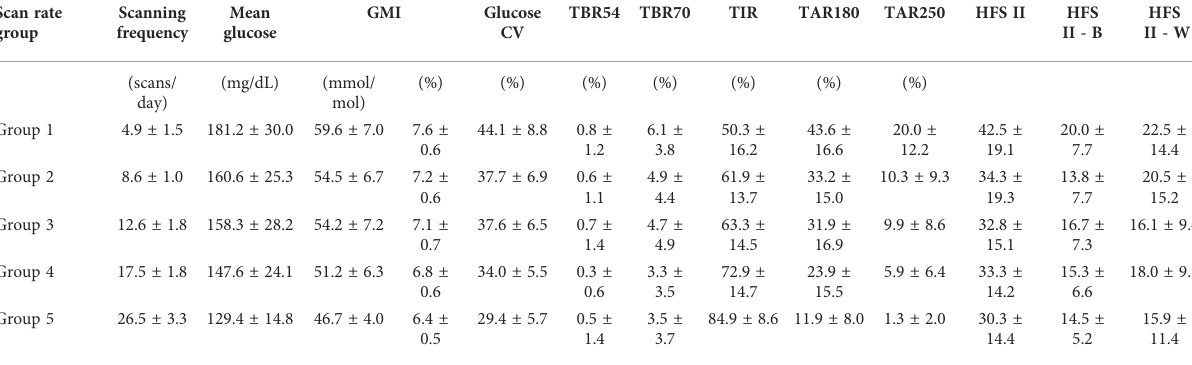
TABLE 2 Glycemic indices and HFS II according to the scan rate group. Scan rate